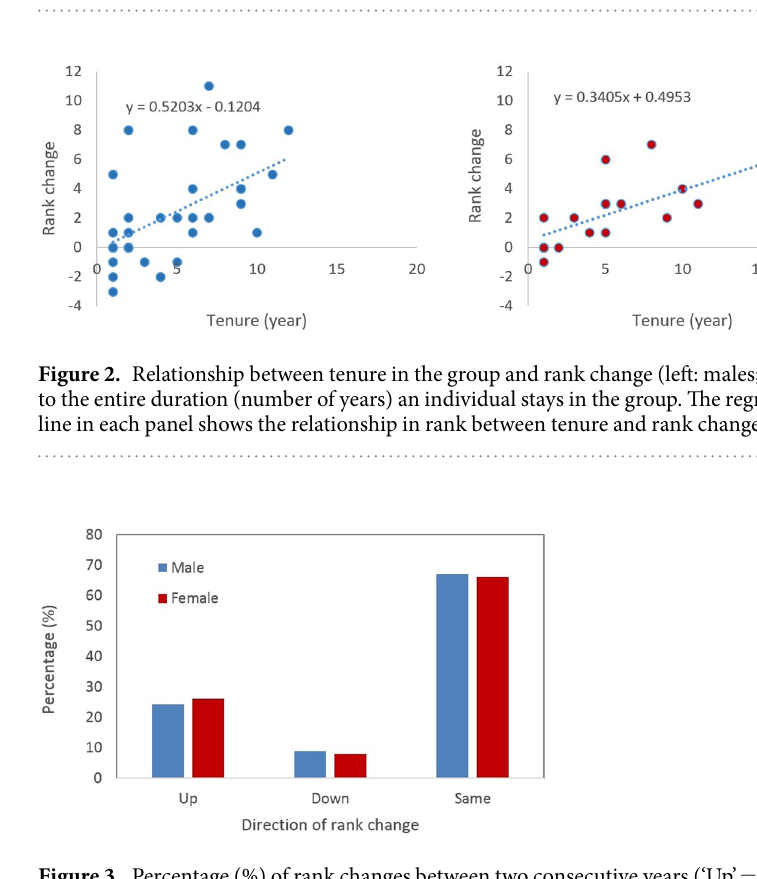
Table 1. Tenure in the group in relation to social mobility.